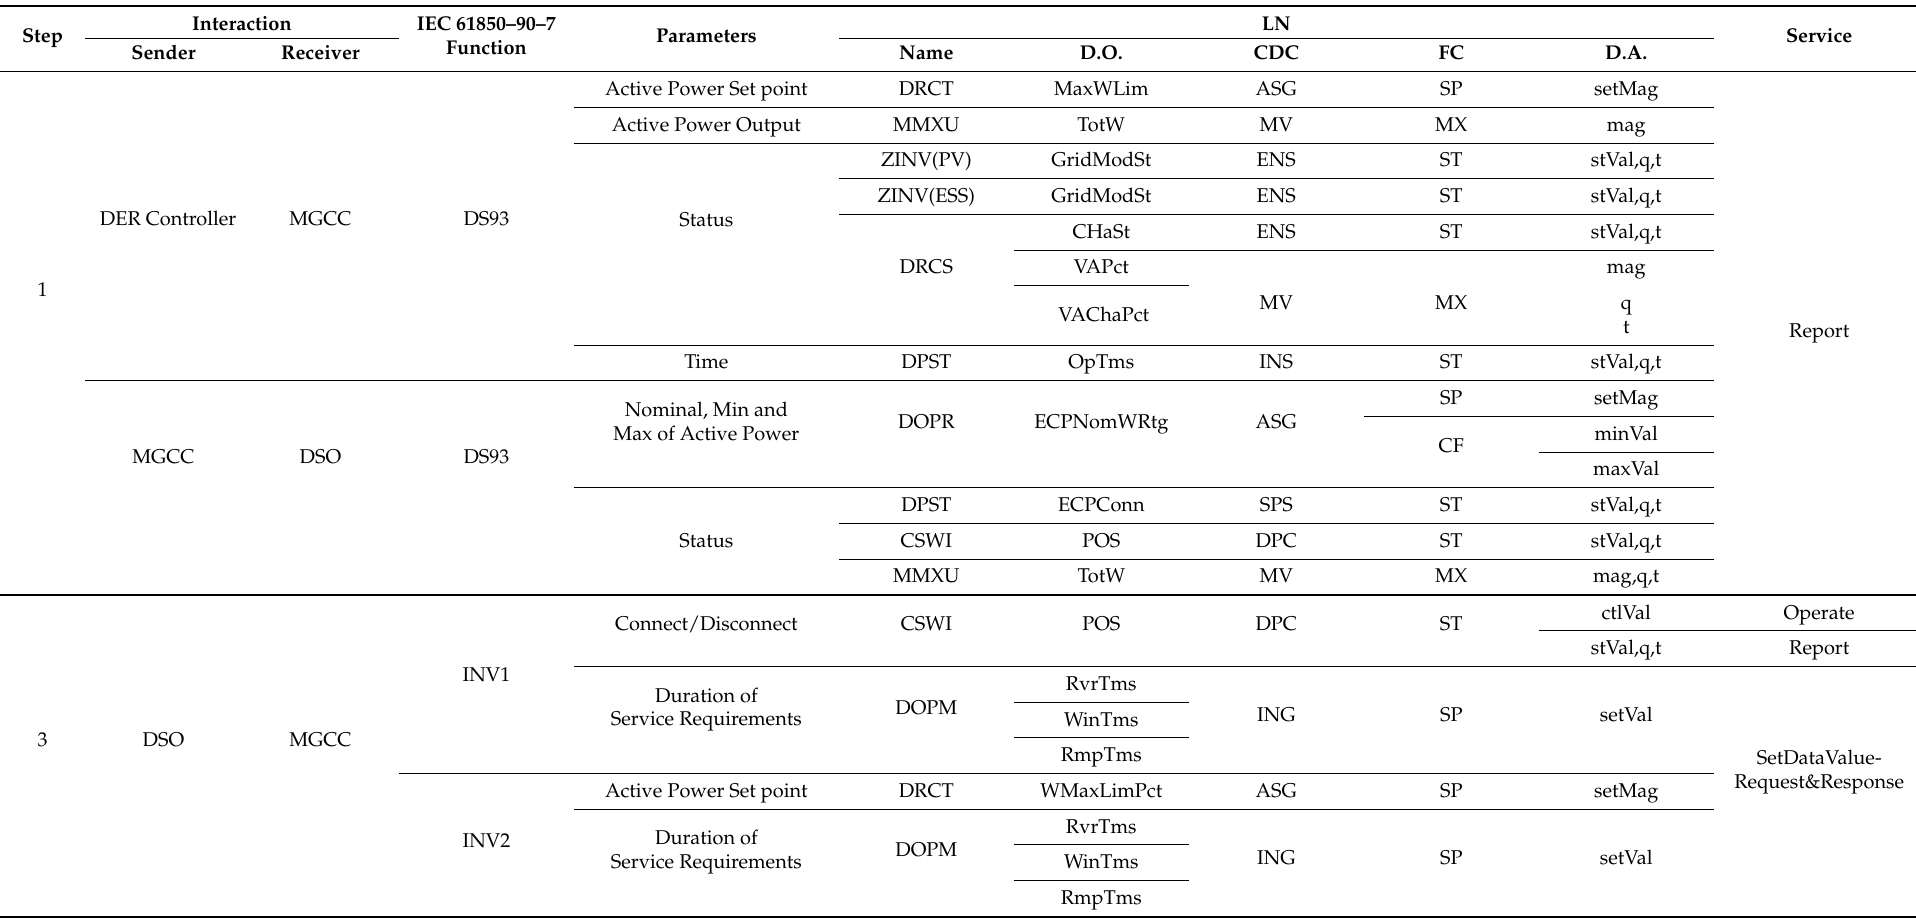
Table 3. Logical nodes and service requirements of micro-grid as